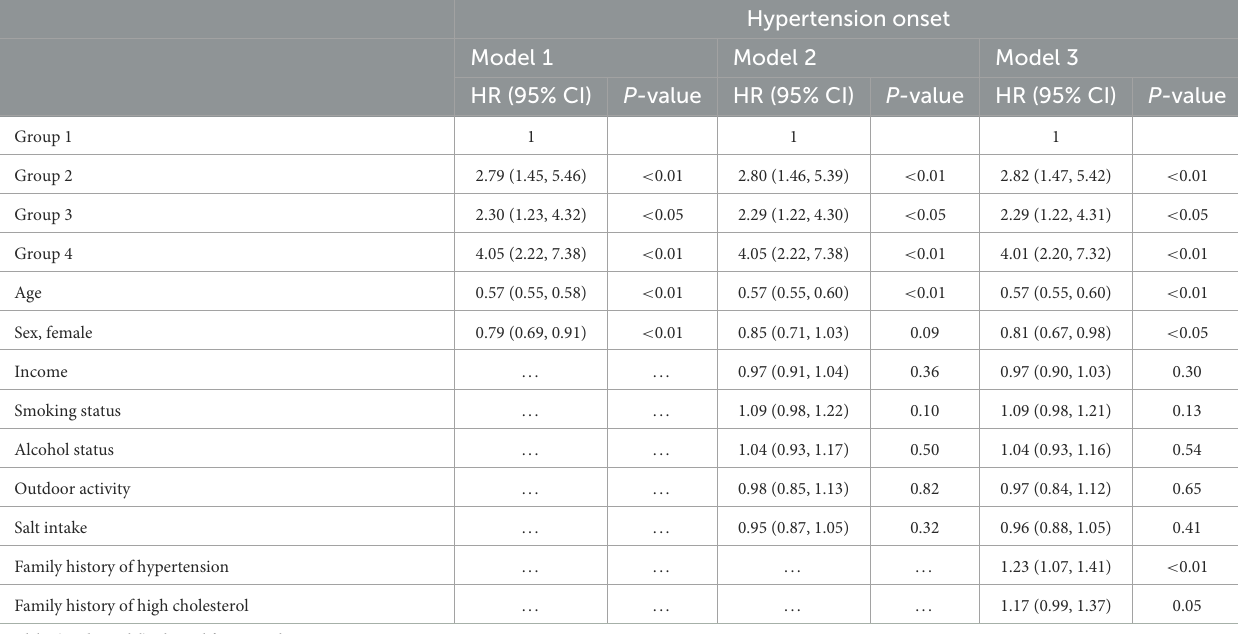
TABLE 3 Cox models indicate the association of obesity status changes with hypertension onset.